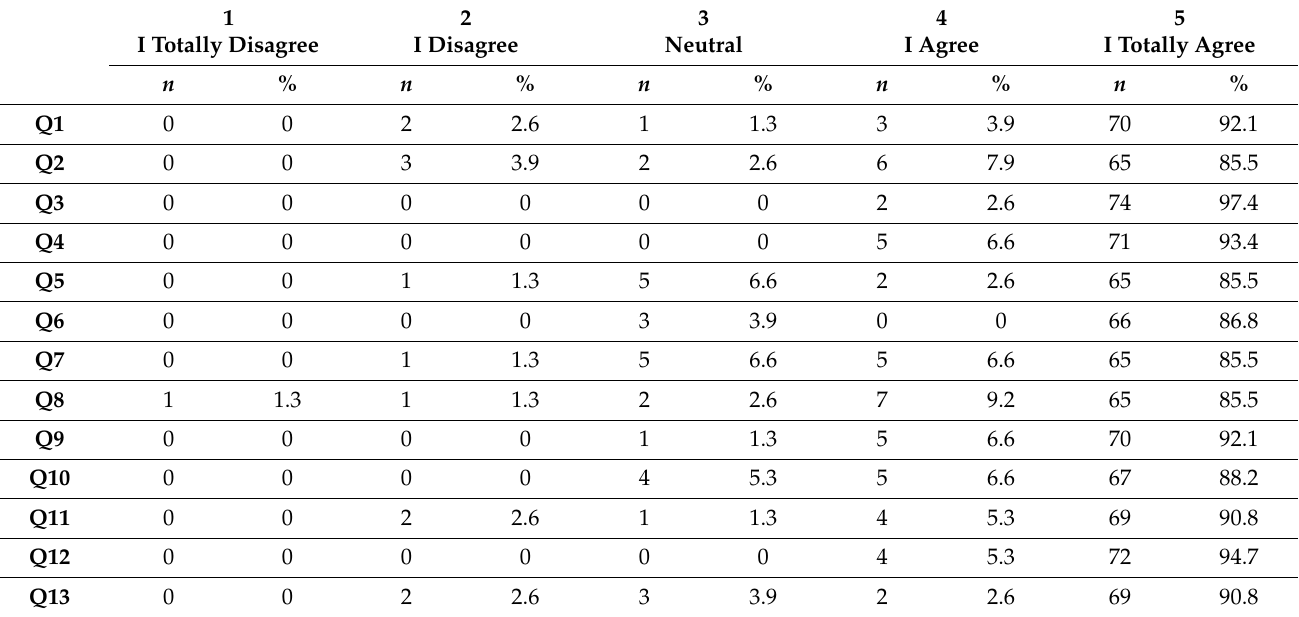
Table 4. Global results from the